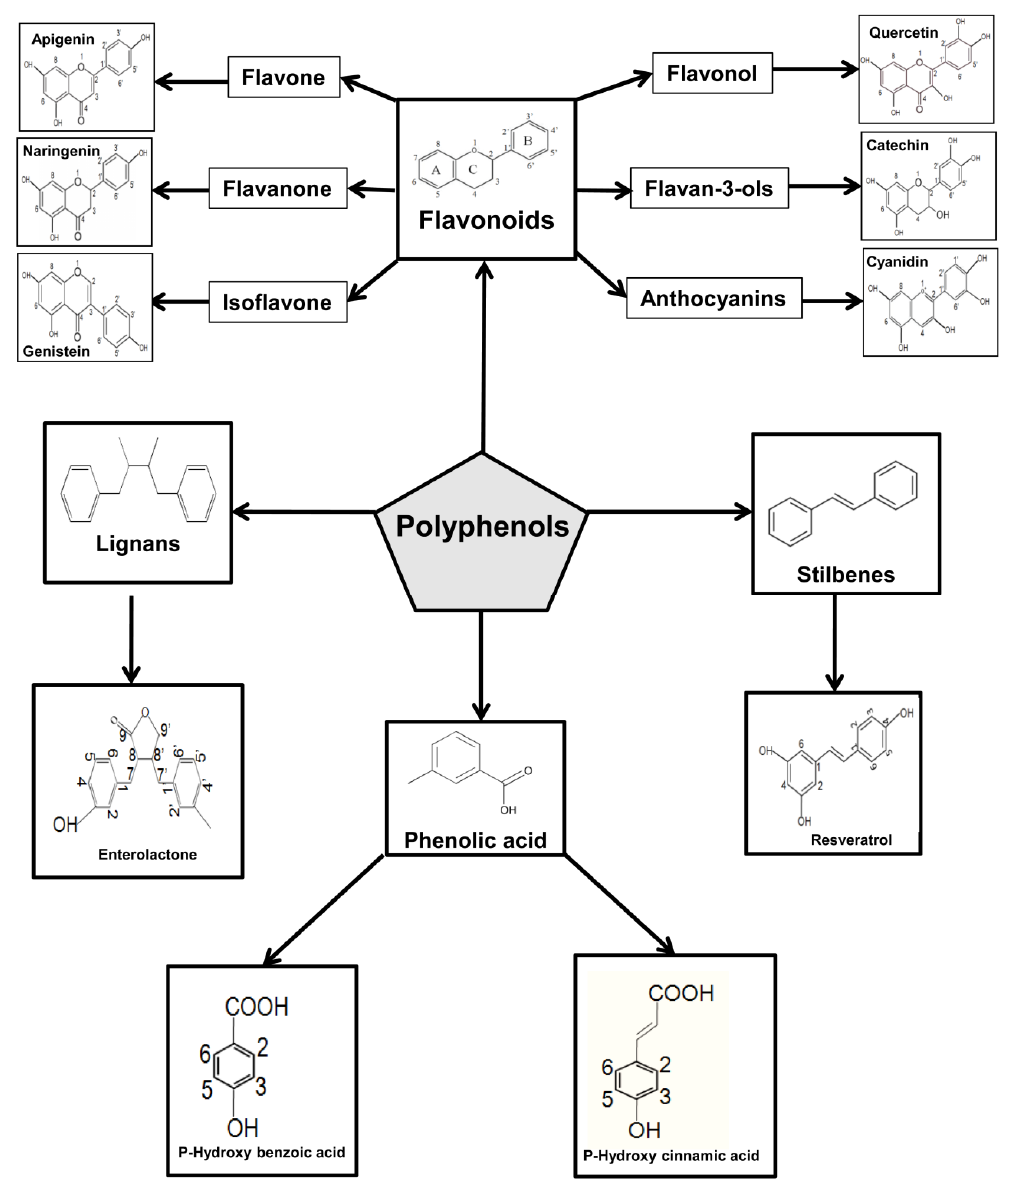
Figure 2. Diagram summarizing the classes of polyphenols and their basic chemical structures.